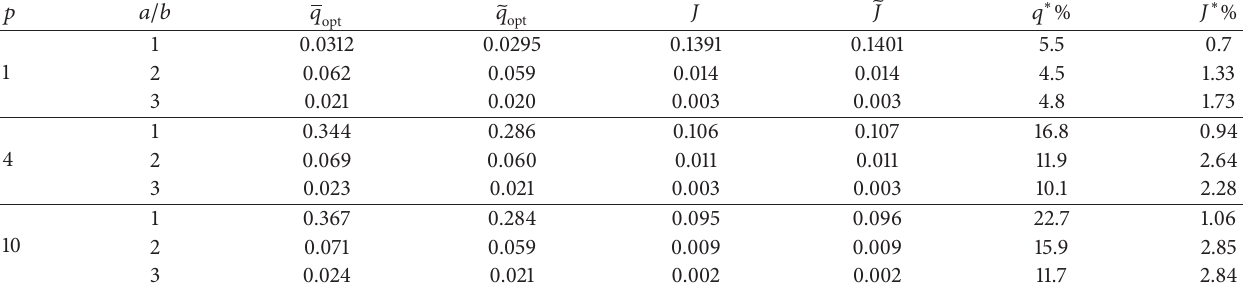
̃𝐽 , ̃𝑞 , 𝐽 , and of simply supported Al/ZrO 2 FG plates with 𝑚 = 𝑛 = 1 , 𝑎/ℎ = 5 . opt opt